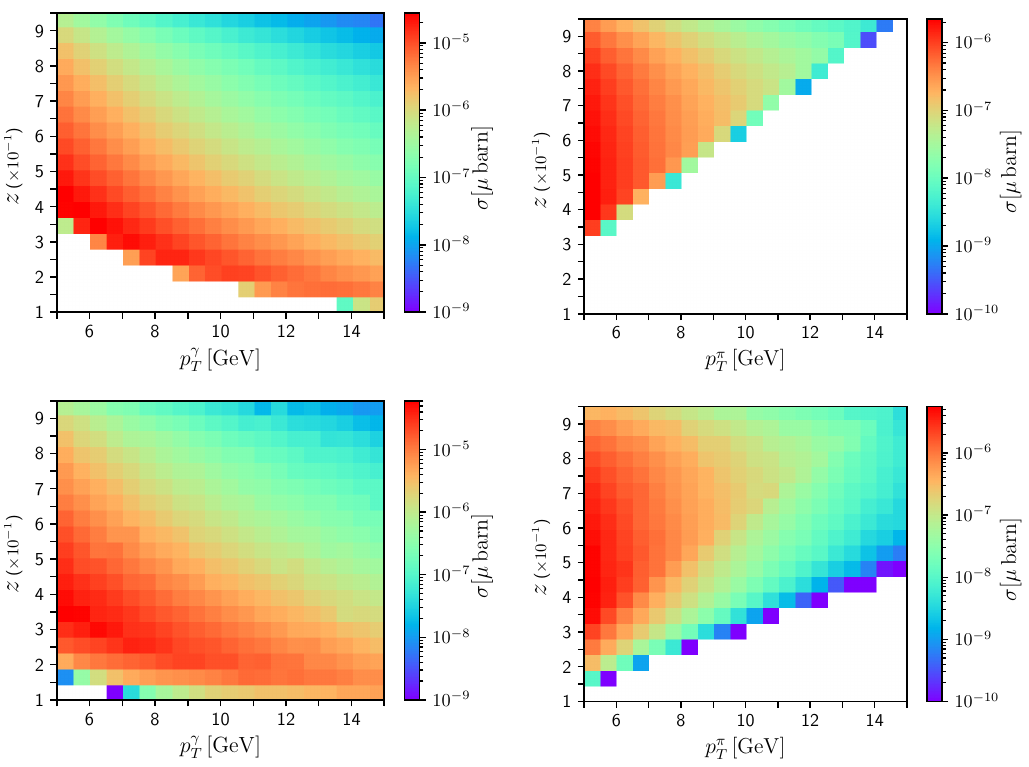
γ (left) and p π (right). The T T (cid:112) = 500 S CM